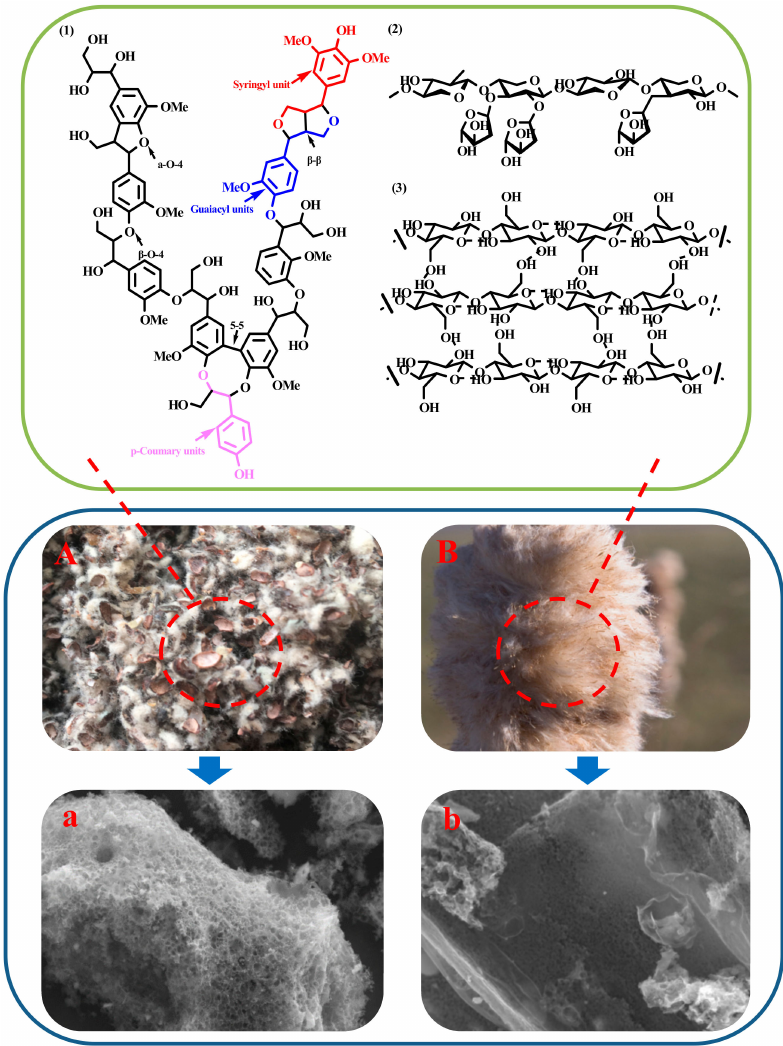
Figure 1. Carbon materials from natural bio-resource ( A ) cottonseed hull; ( B ) cattail; ( a ) porous carbon from A; ( b ) porous carbon from B; ( 1 ) Lignin; ( 2 ) hemicelluloses; ( 3 )